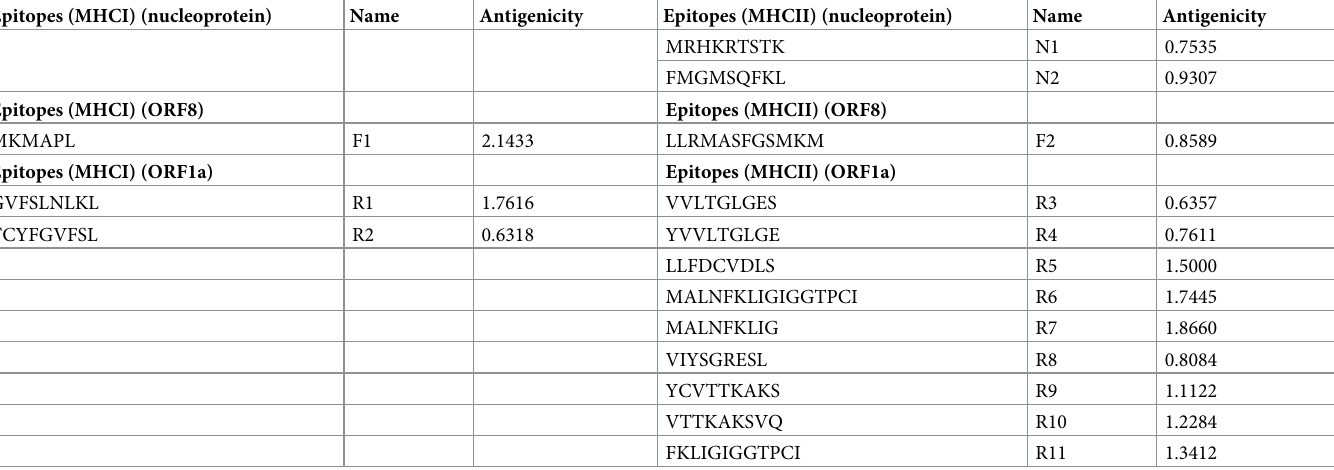
Table 2. Selected 15 T-cell (MHC I & II) epitopes among nucleoprotein, ORF8, and ORF1a proteins. Epitopes (MHCI) (nucleoprotein)